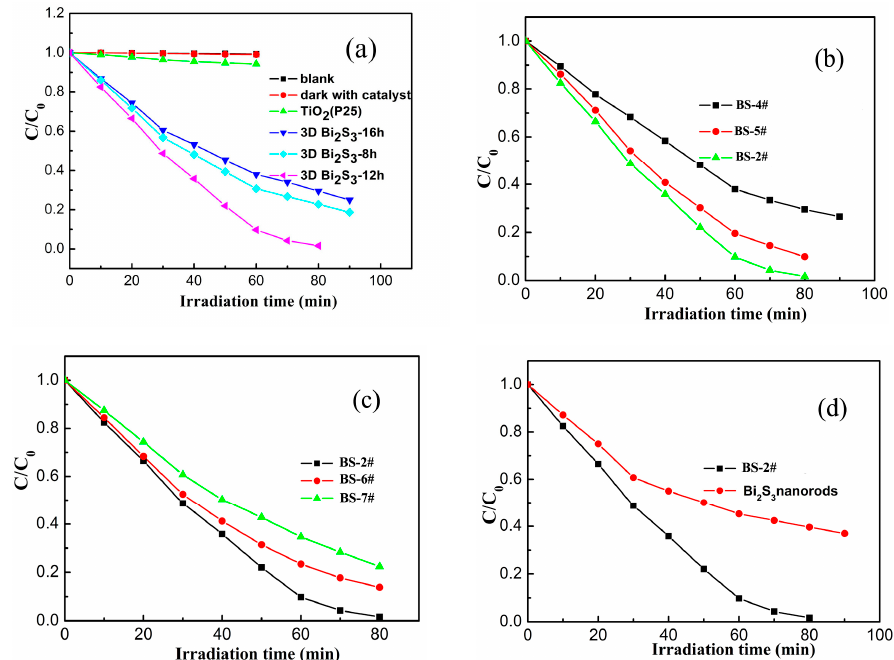
Figure 7. ( a ) The photocatalytic activities of RhB solution in the dark, without catalyst and over the samples of P25, BS-1#, BS-2# and BS-3#; ( b ) the comparison of photocatalytic activity over the samples of BS-2#, BS-4# and BS-5#; ( c ) the comparison of photocatalytic activity of over the samples of BS-2#, BS-6# and BS-7#; and ( d ) the comparison of photocatalytic activity over the samples of BS-2# and Bi 2 S 3 nanorods. Crystals 2016 , 6 , 140